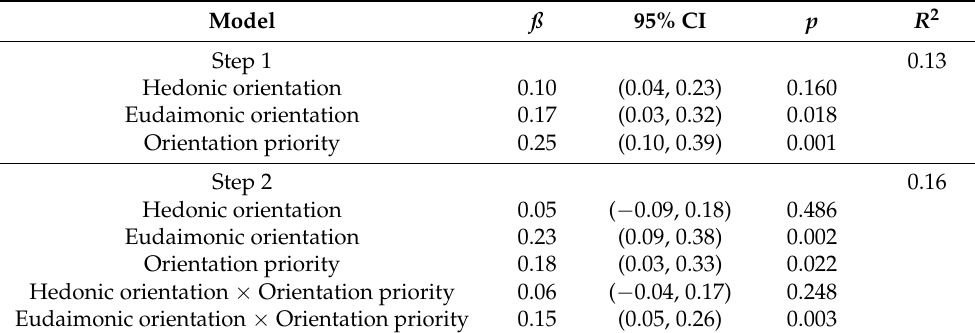
Table 2. Regression results using psychological well-being as a dependent